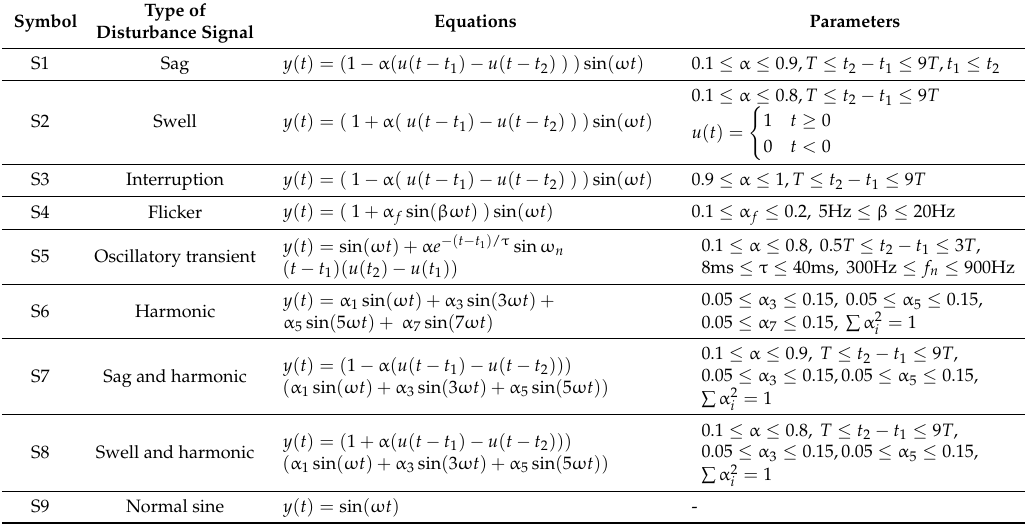
Table 1. Mathematical model of PQ disturbances.